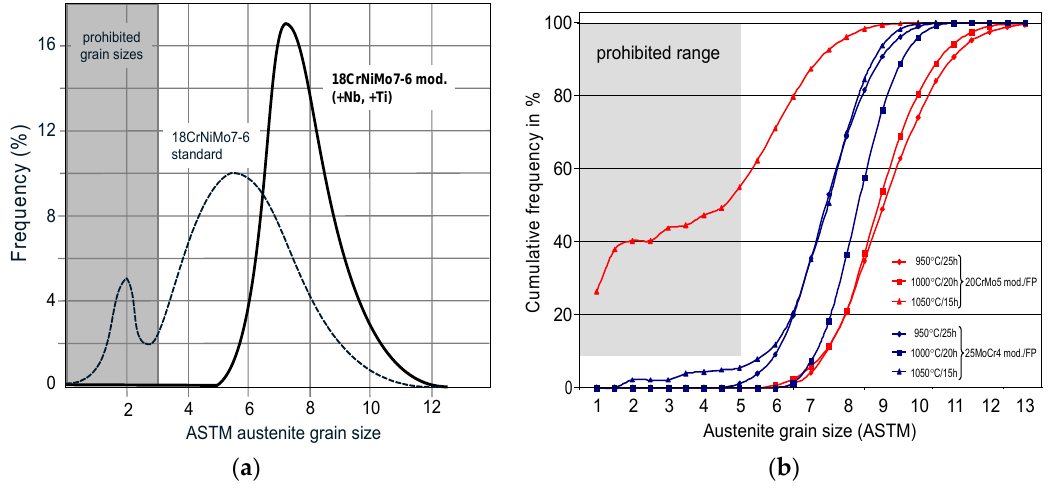
Figure 10. Controlling grain size in carburizing steel: ( a ) grain size distribution of a Nb + Ti microalloyed 18CrNiMo7-6 (1.6587) heat-treated compared to a conventional analysis (carburizing conditions: 1030 °C/25 h); ( b ) grain size stability under various carburizing conditions for Nb microalloyed 20CrMo5 (1.7264) and 25CrMo4 (1.7325).